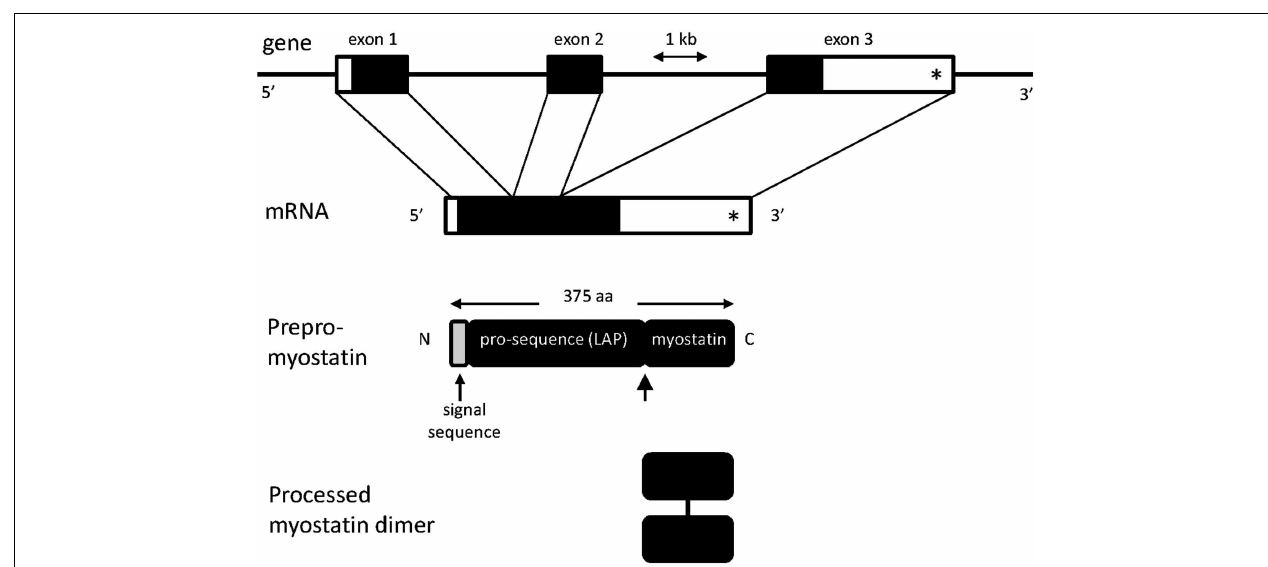
untranslated regions.The lightly shaded region in the prepro-myostatin protein sequence corresponds to the signal sequence. Also shown is the site for processing of the promyostatin protein (thick arrow).The mature myostatin polypeptide forms a dimer held together by a disulfide